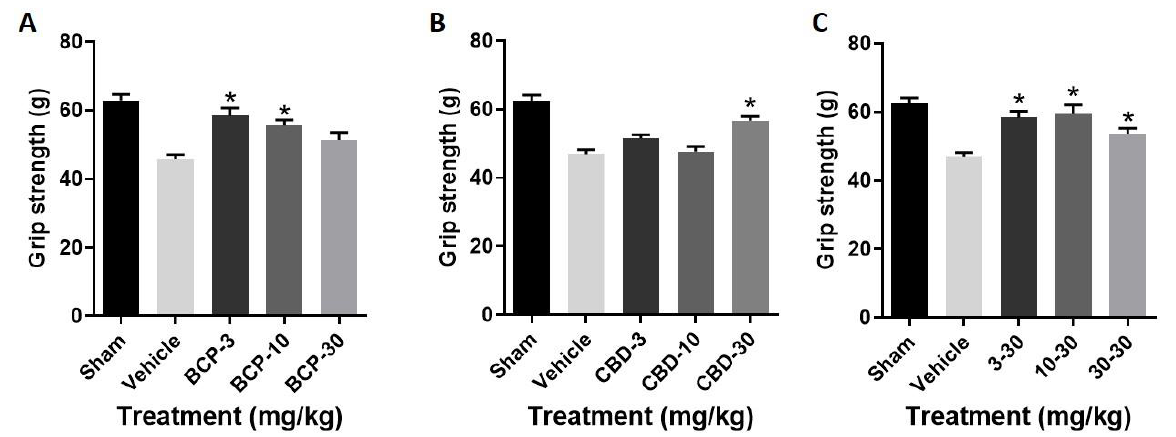
Figure 3. BCP, CBD and BCP + CBD combinations significantly improved grip strength in a mouse model of permanent ischemia (photoinjury). X axis: treatment, Y axis, grip strength in grams. ( A ) BCP treatment led to a significant improvement in grip strength as compared to vehicle treatment (* p = 0.0001). ( B ) CBD treatment led to a significant improvement in grip strength as compared to vehicle treatment (* p = 0.0001). ( C ) BCP + CBD treatment led to a significant improvement in grip strength as compared to vehicle treatment (* p = 0.0001). Data are expressed as mean and SEM and were analyzed utilizing one-way ANOVA with Dunnett’s multiple comparison test.